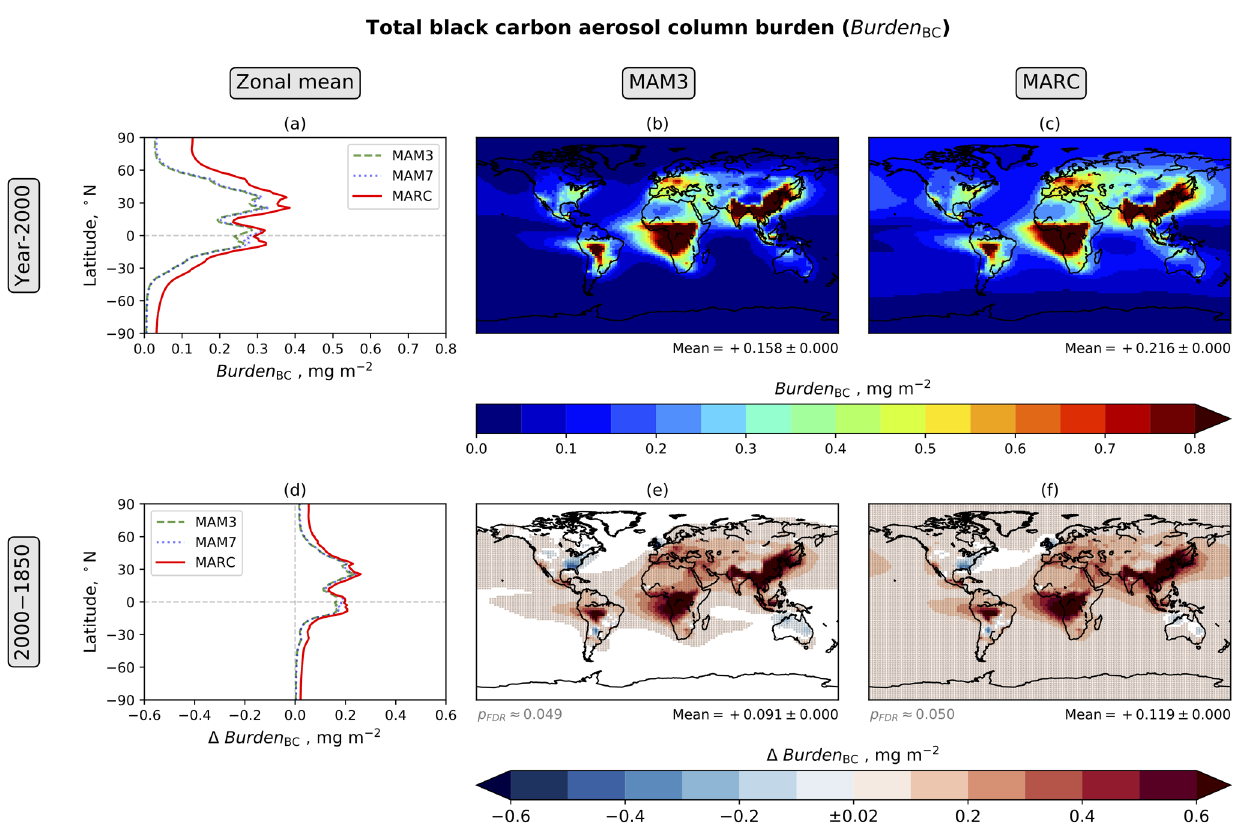
Figure 4. Annual mean total black carbon aerosol burden (Burden BC ). The figure components are explained in the Fig. 2 caption.